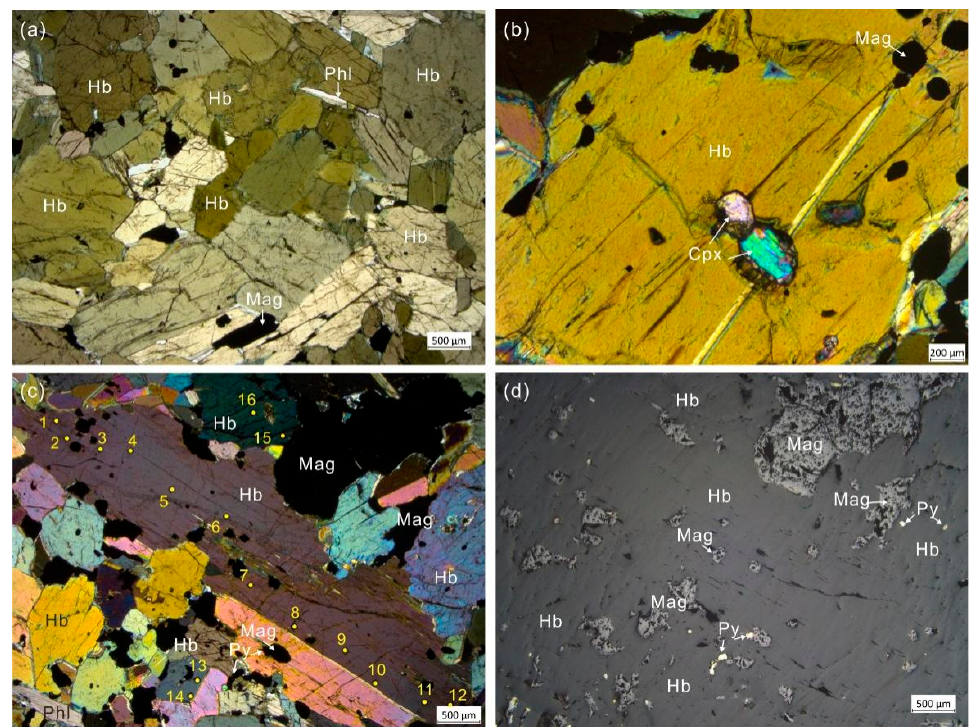
Figure 2. Photomicrographs of the Gaositai hornblendite. ( a ) Massive hornblendite, plane polarized light, ( b ) clinopyroxene and magnetite inclusions in hornblende, cross polarized light, ( c ) coarse- and fine-grained hornblendes, locations of in situ major and trace elements analyses, cross polarized light, ( d ) Magnetite and pyrite in hornblendite, reflected light. Cpx—clinopyroxene, Hb—Hornblende, Mag—magnetite, Phl—phlogopite, Py—pyrite.